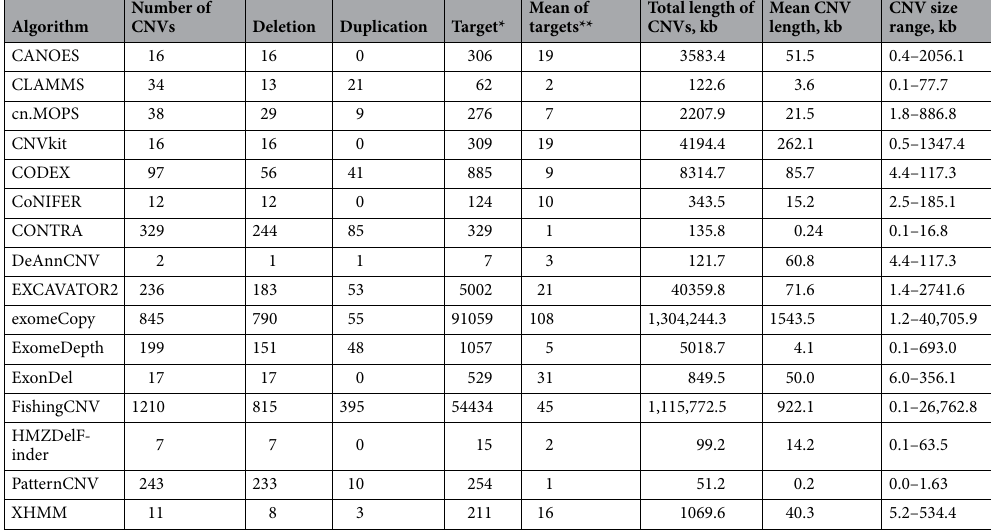
Table 3. Description of predicted CNVs. *Target, number of target regions covered by all predicted CNVs. **Mean of target, average number of target regions covered by a